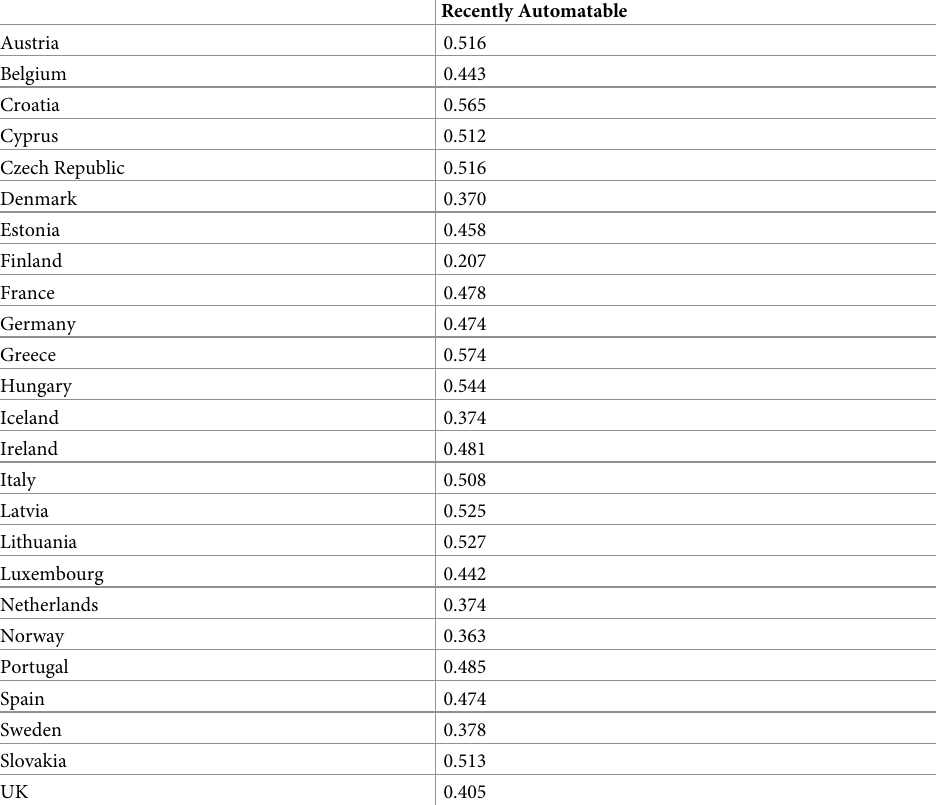
Table 1. Lordan and Josten (2020) shares of employment in 2013–2016 by country.